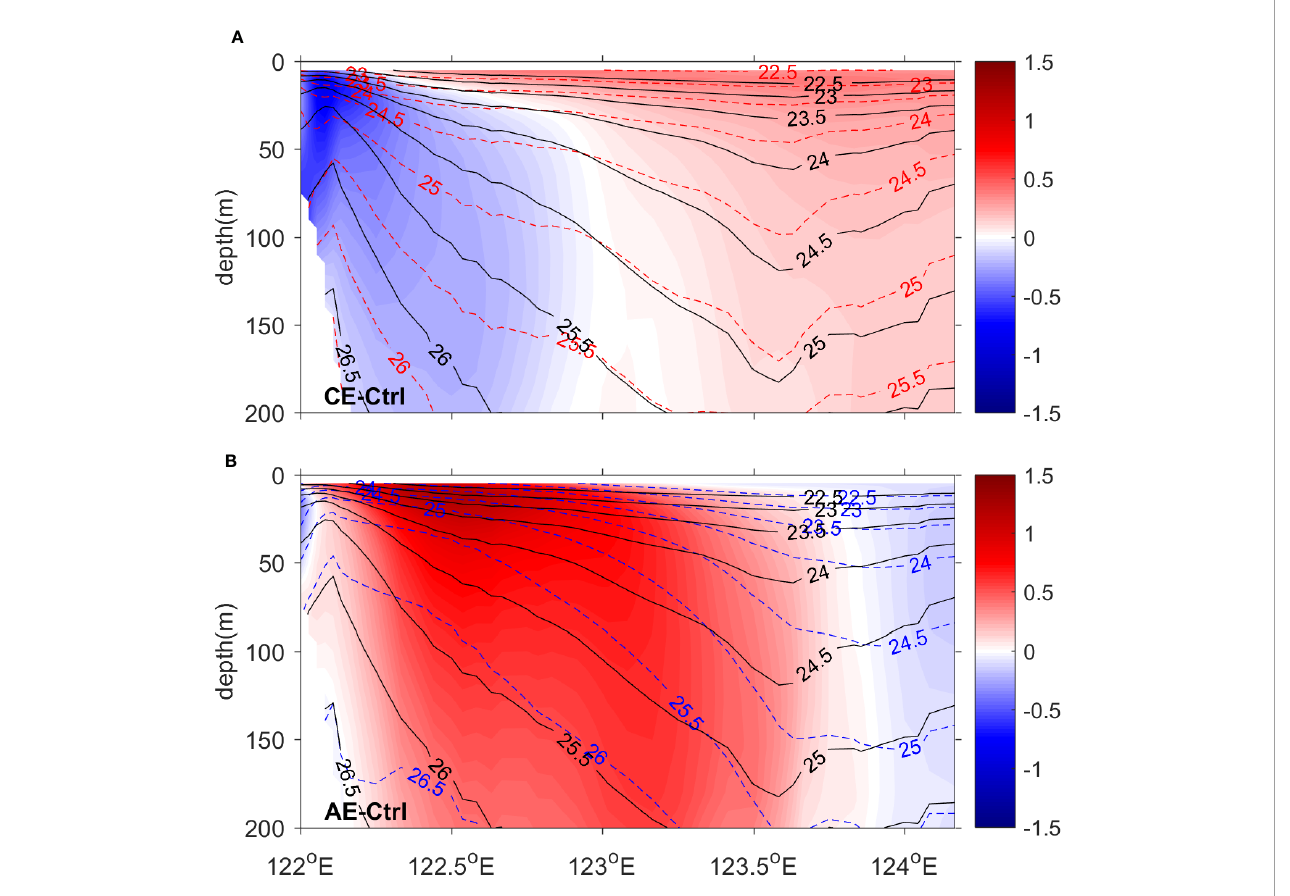
FIGURE 10 Difference in density (kg/m 3 ) along the 200 m isobaths between (A) the CE and Ctrl experiments and (B) the AE and Ctrl experiments. The density contours in the Ctrl, CE, and AE experiments are labeled by black solid lines, red dashed lines, and blue dashed lines,